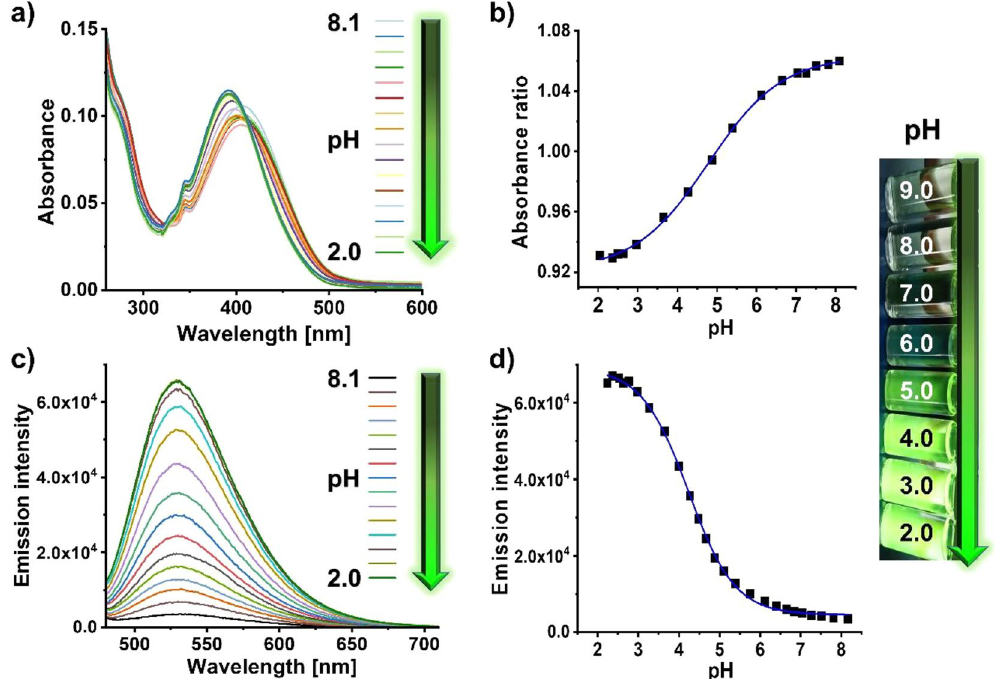
Figure 2. pH-dependent spectroscopic properties of fluorescent probe 3 ; ( a ) absorption spectra (25 µM) at different pH values; ( b ) plot of the absorbance ratio (405 nm/390 nm) at different pH values; ( c ) emission spectra (0.13 µM) at different pH values; and ( d ) emission intensity (λ Ex = 405 nm) at different pH values used to calculate the pK a of the optical probe. The inset shows a photograph of the color changes of the emission of 3 under UV light at different pH values that can be detected by naked